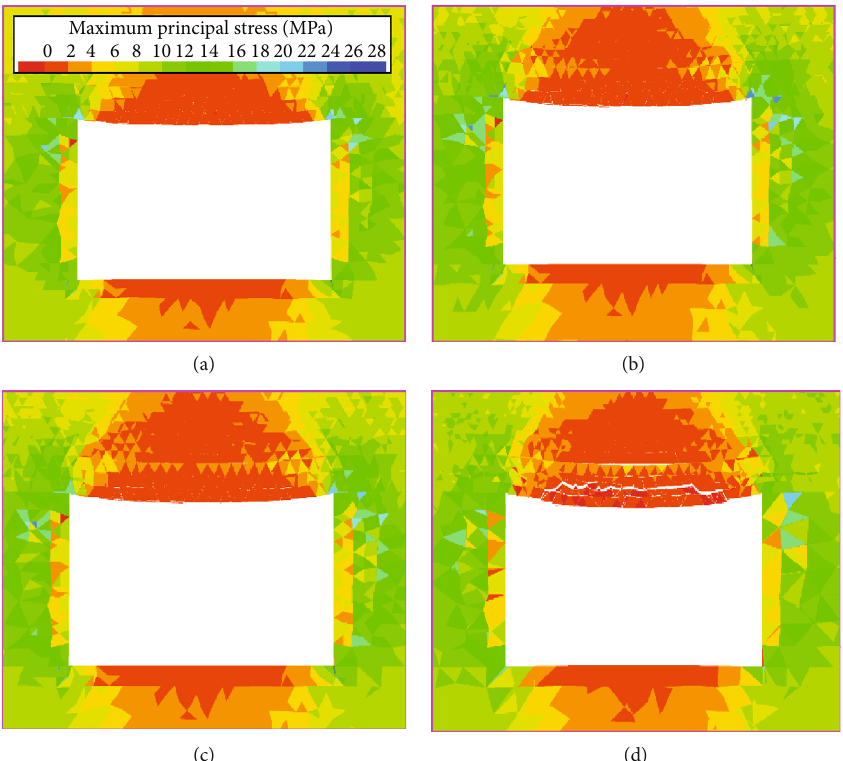
Figure 11: Maximum principal stress distribution in surrounding rocks of the roadway after model operation for di ff erent steps. (a) 500 steps.